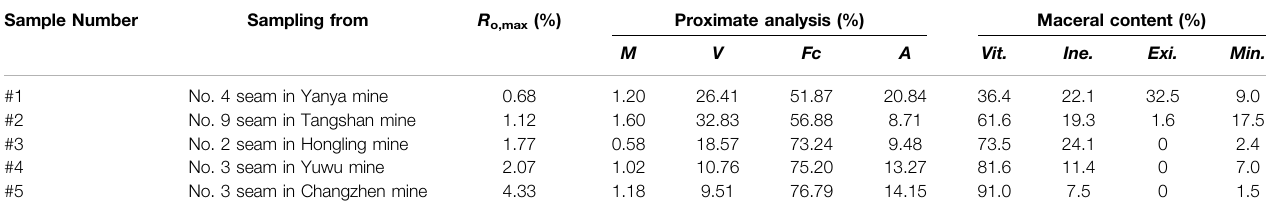
TABLE 1 | Sampling sites and properties of samples.